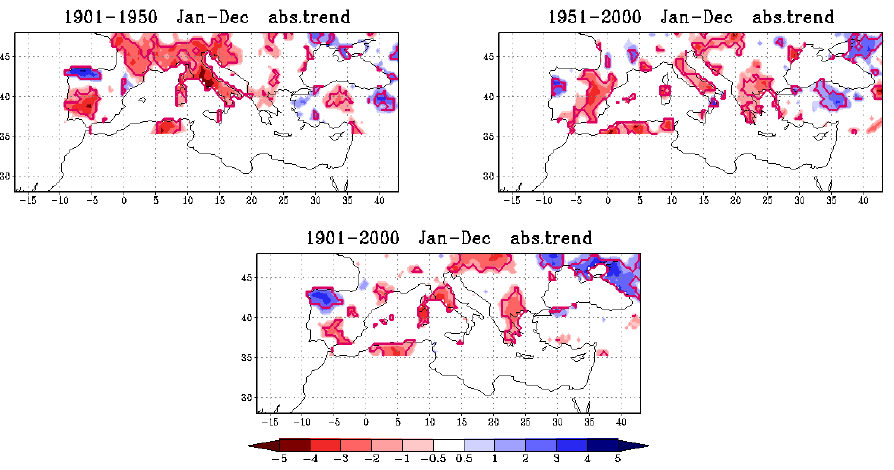
Fig. 2. Mean annual scPDSI absolute trends for the 1901–1950, 1951–2000, and 1901–2000 (down) periods – statistical significance as